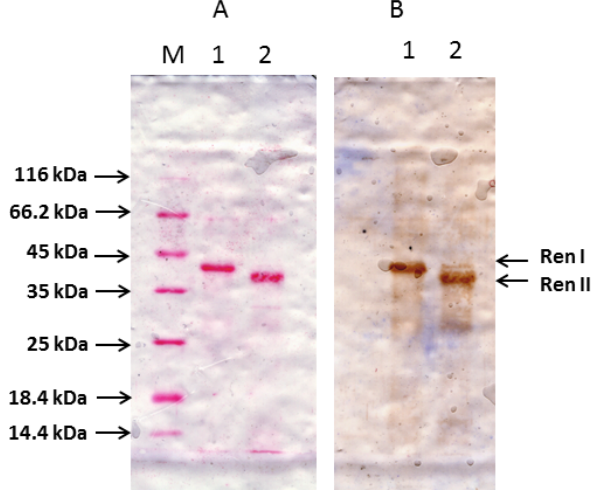
Figure 6. Western blot analysis of hRenalase1 and hRenalase2 using sheep polyclonal antibodies against hRenalase1. ( A ) Staining of the nitrocellulose membrane with Ponceau S after electrotransfer from the SDS-PAGE gel; Track 1—polyHis hRenalase1 (RenI—39 kDa); Track 2—polyHis hRenalase2 (RenII—36 kDa); Track M—molecular mass marker; mass values are shown on the left; ( B ) Western blot analysis with sheep polyclonal antibodies against